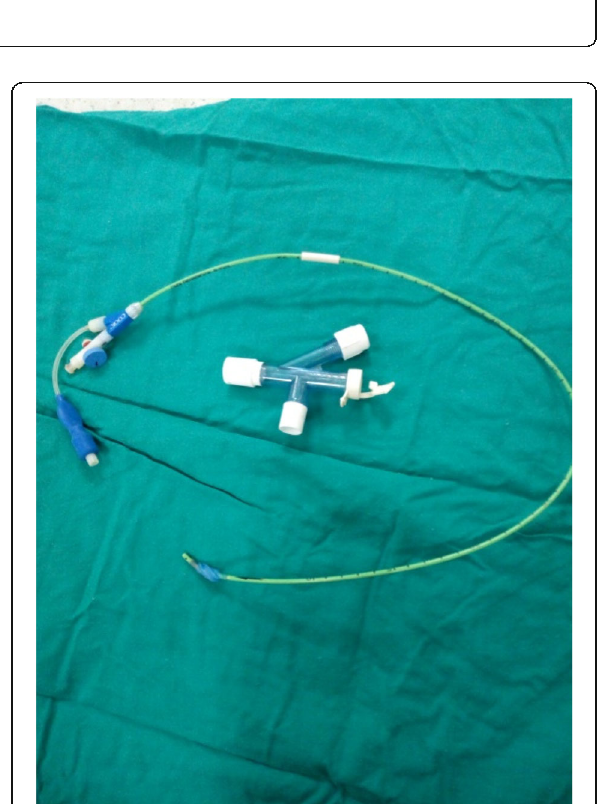
Fig. 1 Flow chart of the randomized study